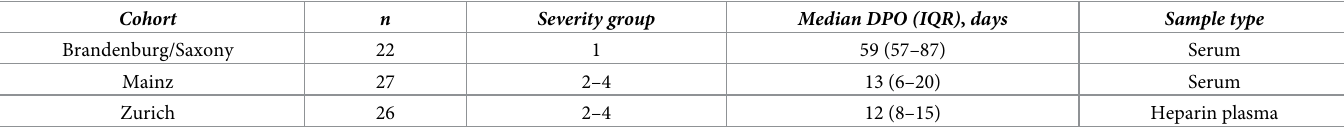
Table 2. Number of samples (n), severity group, and median day post onset (DPO) of symptom of patients who contracted SARS-CoV-2, belonging to three cohorts (IQR, interquartile range). Cohort